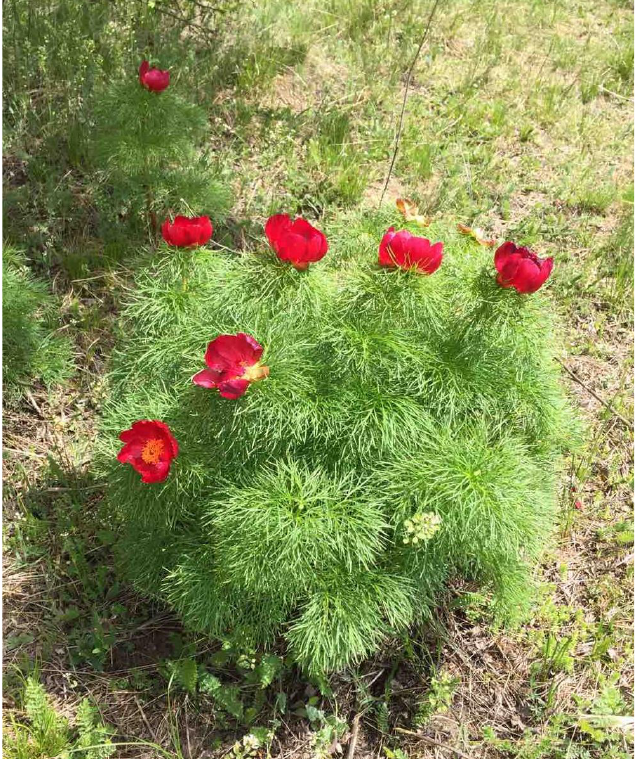
Figure 4. Full blooming Paeonia tenuifolia L., at locality Deliblato sands, Serbia (May 2022).